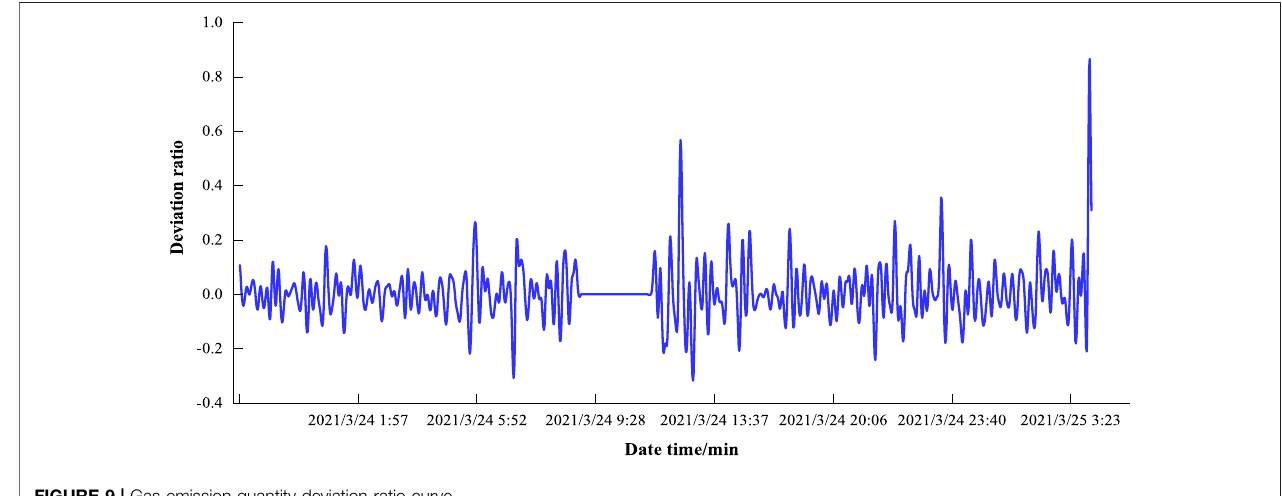
FIGURE 9 | Gas emission quantity deviation ratio